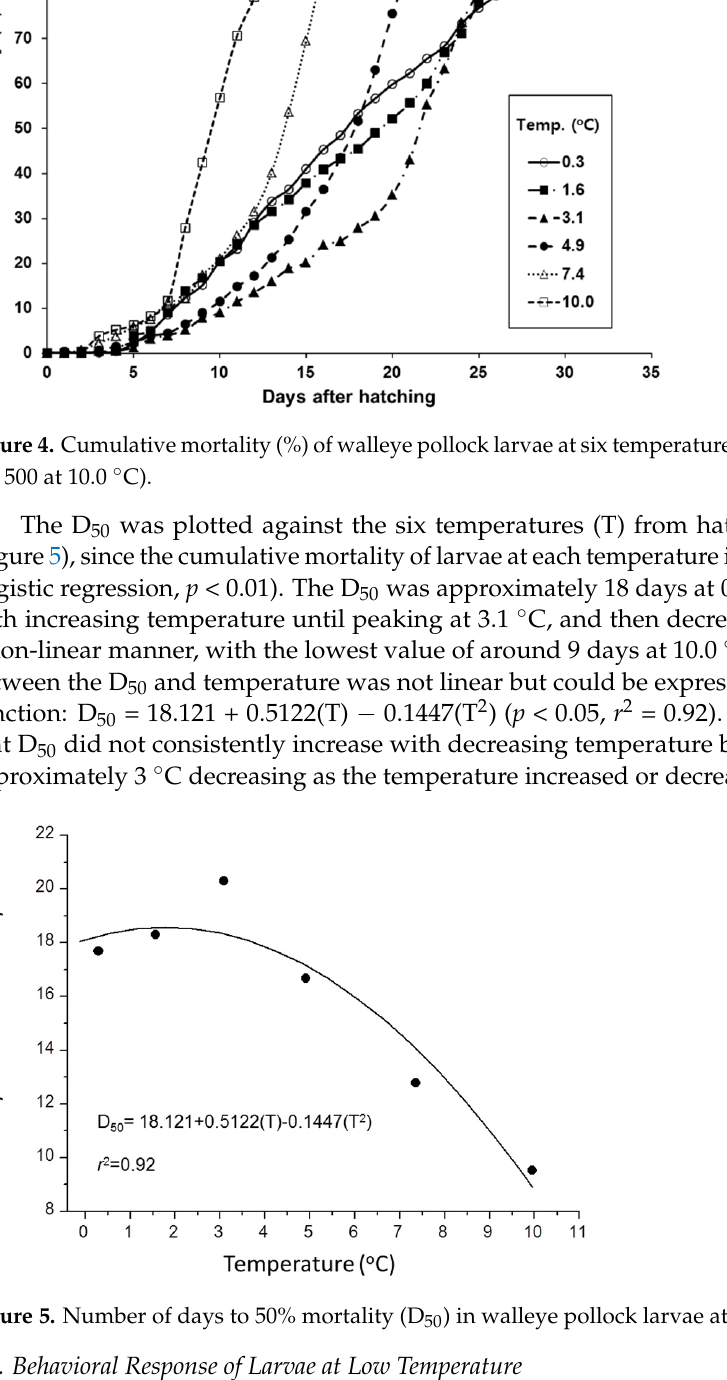
Figure 4. Cumulative mortality (%) of walleye pollock larvae at six temperatures ( n = 600 at 0.3–7.4 °C; n = 500 at 10.0 °C).